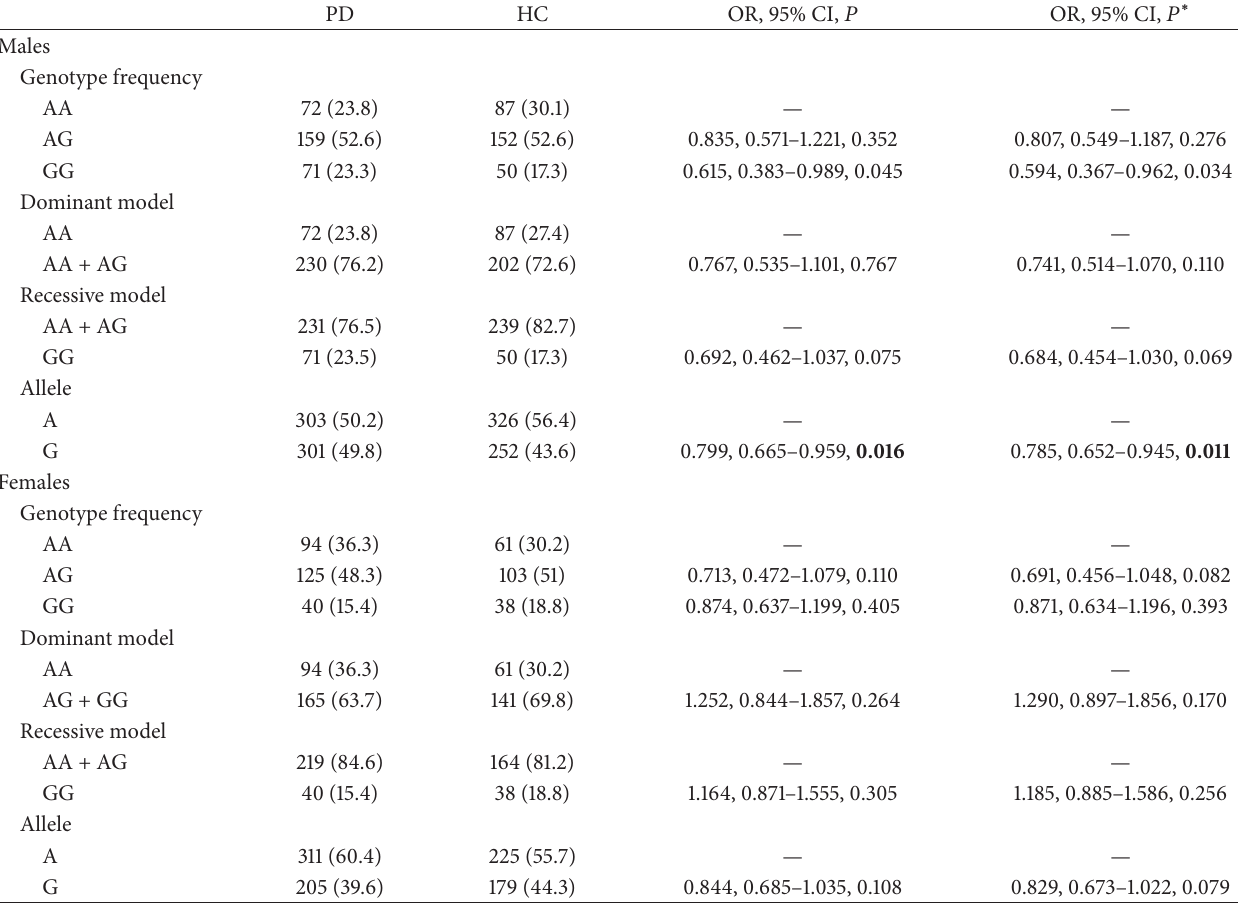
Table 3: Distribution of genotype and alleles at rs363371 in Han Chinese PD patients and controls, stratified by